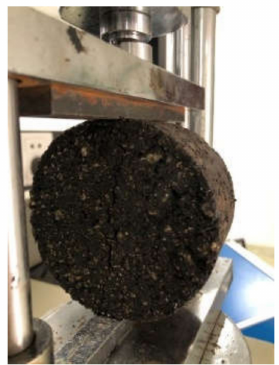
Figure 4. Indirect tensile strength (ITS)